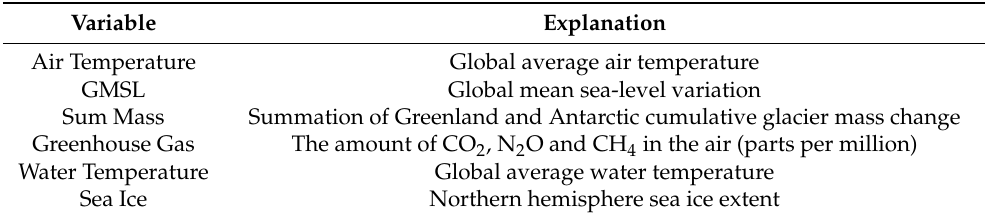
Table 1. Definition of global variables used in the proposed analysis pipeline. The only variable not included are regional sea levels measured by various regional tidal gauge stations.